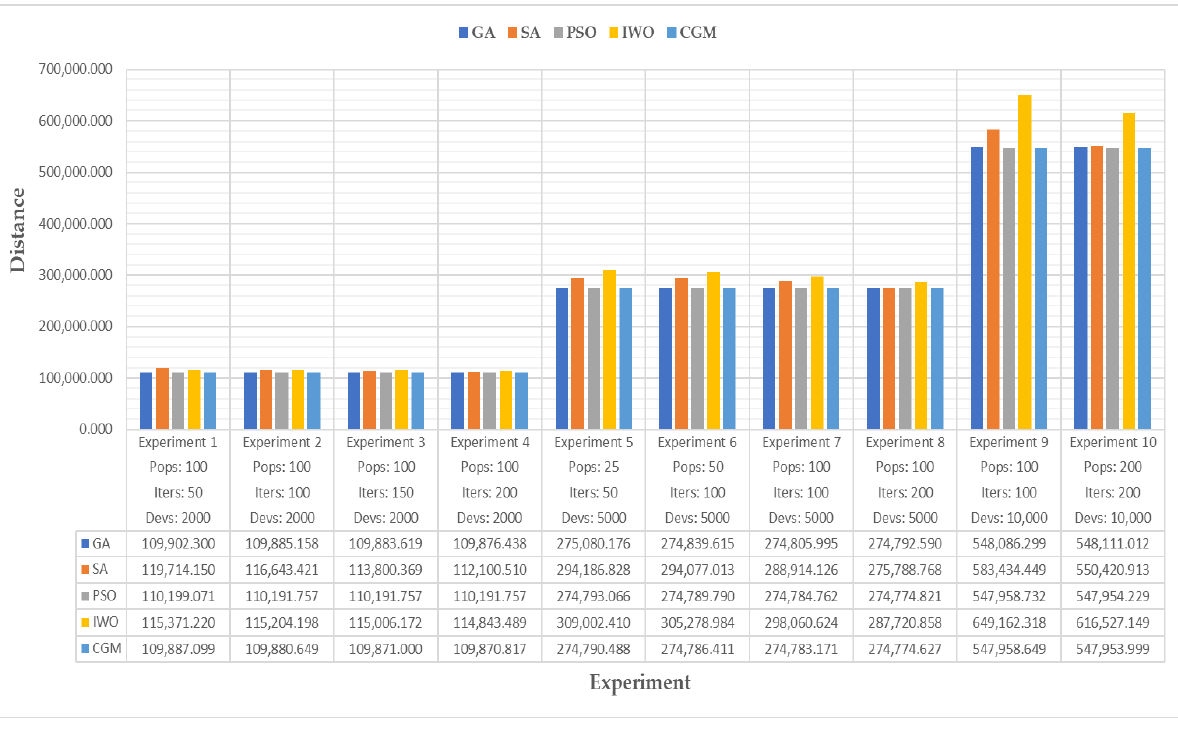
Figure 3. Evaluation results of the optimal-placement-of-resources problem. Table 4. Results of several runs of all optimization algorithms on a single configuration for the op- timal-placement-of-resources problem in a ten-dimensional space.